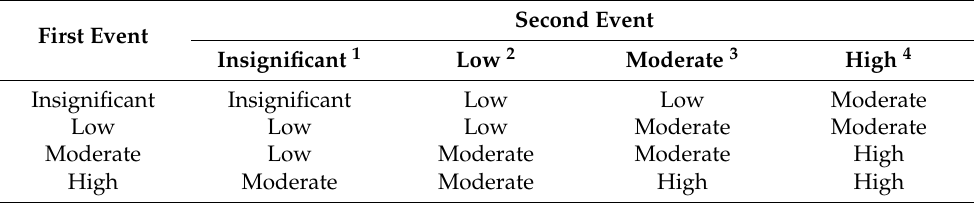
Table 2. Combination matrix generated to unify the conditional-independent risk estimates, which include factors that assume that the second event (i.e., node) is independent of the previous event (first event), although it may be affected if the first event occurs.